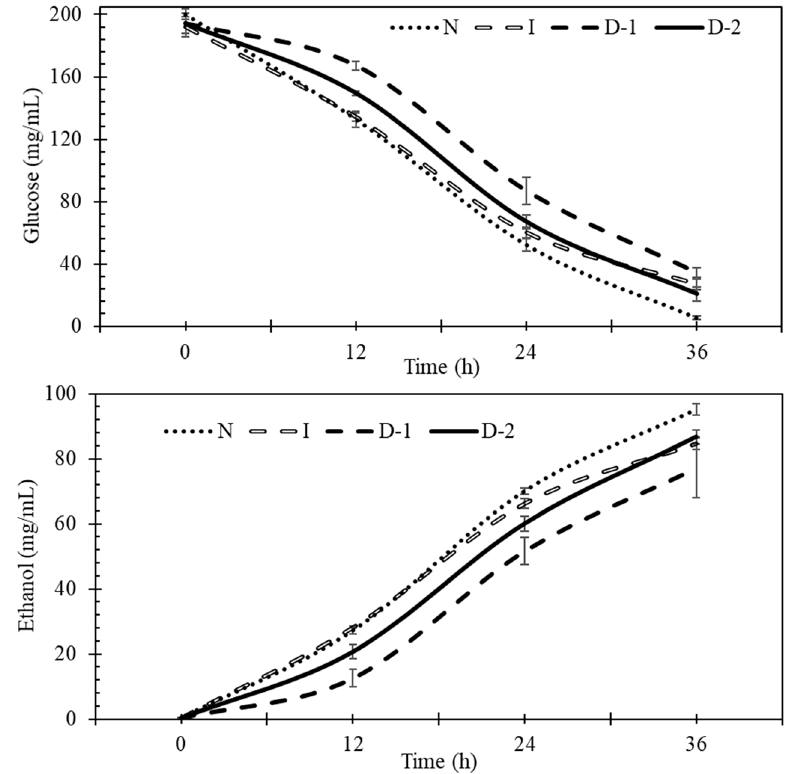
Figure 3. Glucose and ethanol concentrations during fermentation. No-ultrasound (N), indirect ultrasound (I), direct ultrasound 1 (D-1), and direct ultrasound 2 ultrasound (I), direct ultrasound 1 (D-1), and direct ultrasound 2 (D-2).